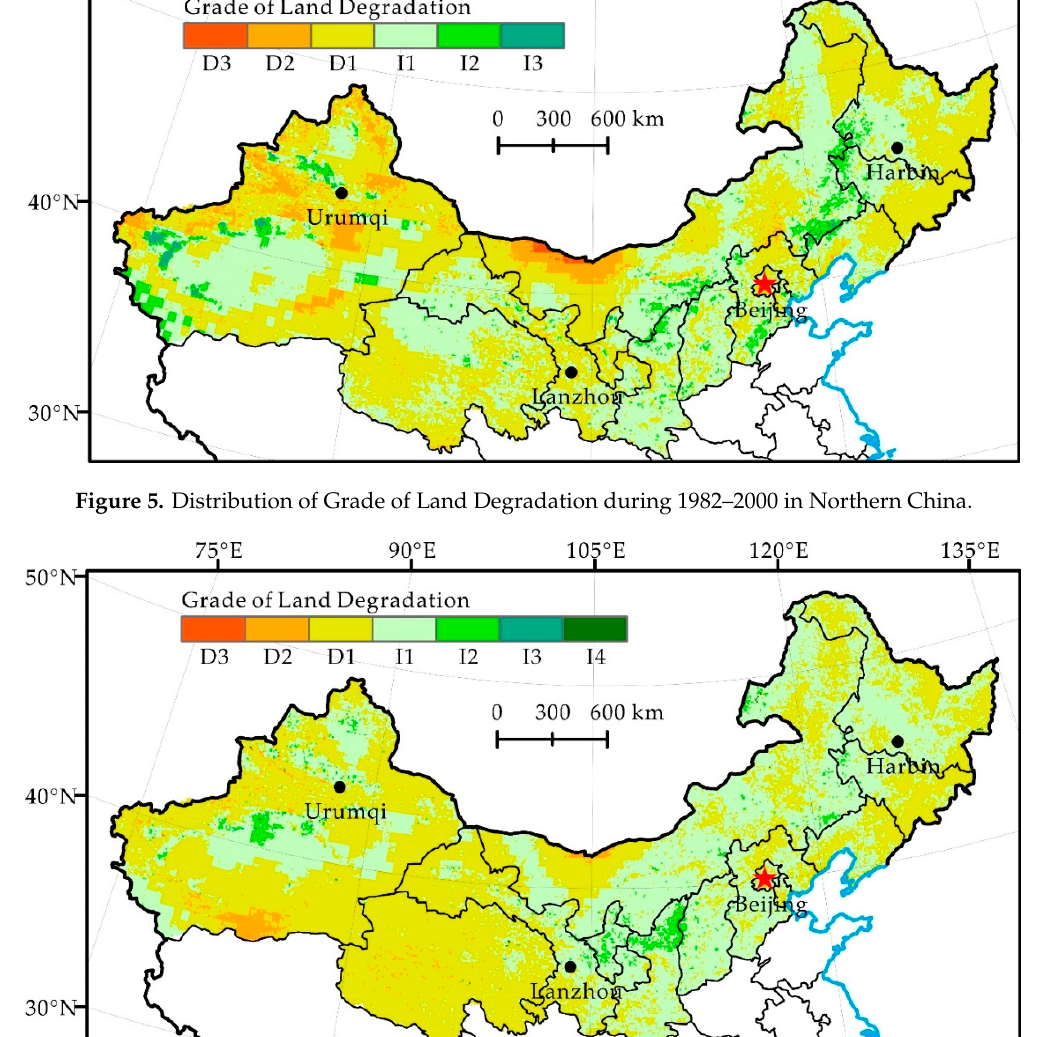
Figure 5. Distribution of Grade of Land Degradation during 1982–2000 in Northern China.